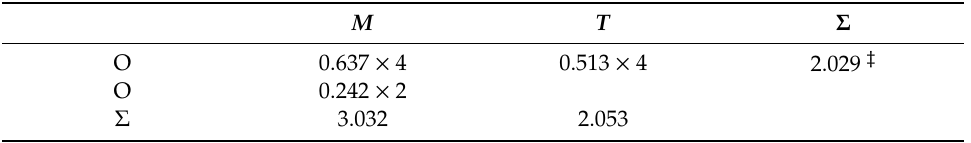
Table 8. Bond-valence sums (BVS; vu) † for hausmannite